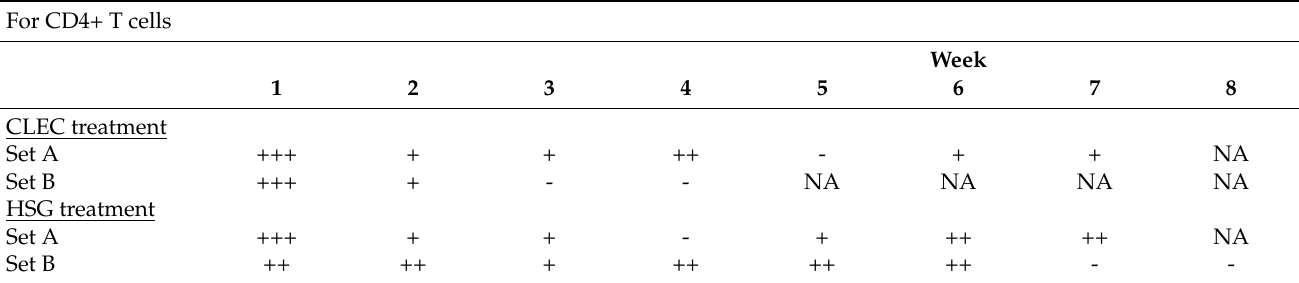
Figure 6. Immunohistochemical (IHC) stains of CD4 and CD8 on tissue biopsies from pig wounds treated with CLECs (CLEC), human skin grafts (HSG), and standard dressings (“Untreated”). Inset: higher magnification (20×). Main scale bar = 500 µm and inset scale bar = 50 µm. Table 3. Distribution levels of CD4+- and CD8+-T lymphocytes infiltration into wound bed via representative tissue biopsies of each treated arm.